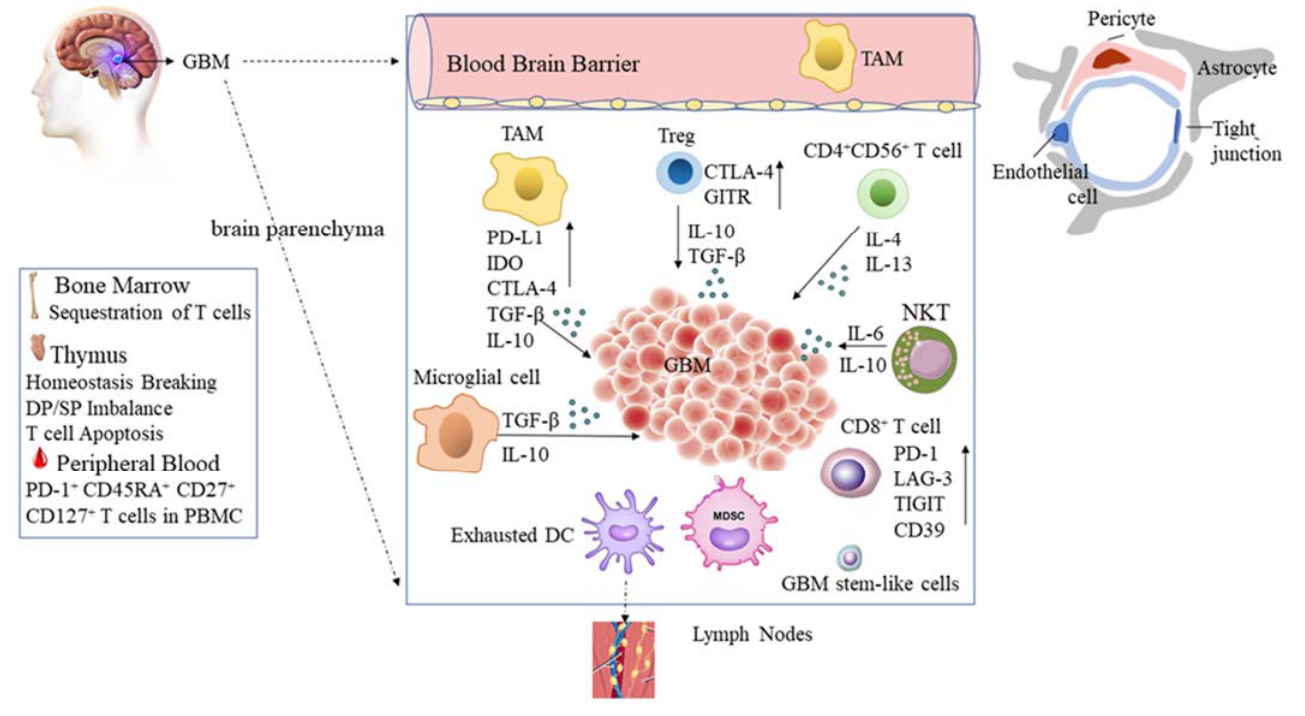
Figure 1. Immunosuppression in glioblastoma. The blood–brain barrier is formed by vascular endothelial cells, pericytes, and astrocytes. In the systemic human body, the sequestration of T cells in the bone marrow, the hemostasis breakdown in double negative (DP)/single positive (SP) T cells in the thymus contribute to the immune ‐ suppressive environment. In the local brain parenchyma, the glioblastoma exits four morphic cell types, indicating differential dysfunctions. The surface expression of programmed cell death 1 ligand 1 (PD ‐ L1) and indolamine 2,3 ‐ dioxygenase (IDO) increased while presentation molecule MHC expression decreased. Additionally, increased secretion of TGF ‐β assists in immune escape from glioblastomas. Tumor ‐ associated macrophages (TAMs) and regulatory T (Treg) cells also facilitate the increase of inhibitory immune checkpoints and secrete TGF ‐β and IL ‐ 10, which downregulate the activation of effector T cells. Exhausted dendritic cell (DC) expression inhibitory immune checkpoints may exaggerate immune resistance in the draining lymph nodes. Furthermore, the presence of infiltration T lymphocytes (TILs), Tregs and CD4 + CD56 + T cells with production of IL ‐ 4 and IL ‐ 13, are associated with the induction of GM ‐ CSF secretion by myeloid suppressor cells. Overall, glioblastoma appears to be a highly immunosuppressive tumor. The figure is adapted from reference [15–17,24–32].